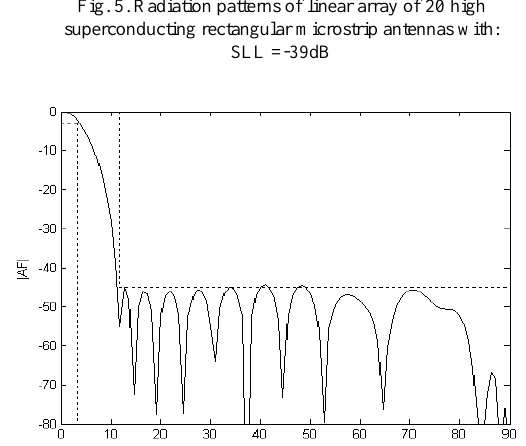
Fig. 5. Radiation patterns of linear array of 20 high superconducting rectangular microstrip antennas with: